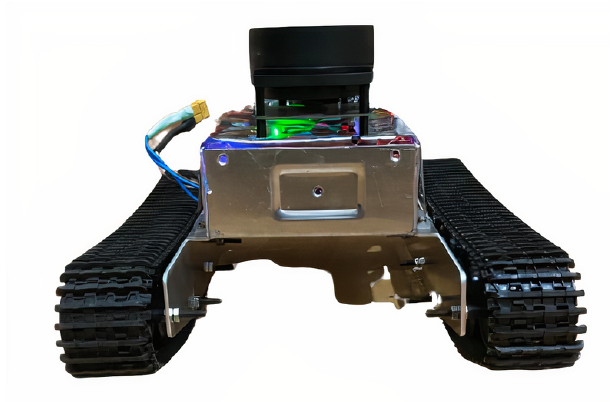
Figure 4. Sample of the Designed